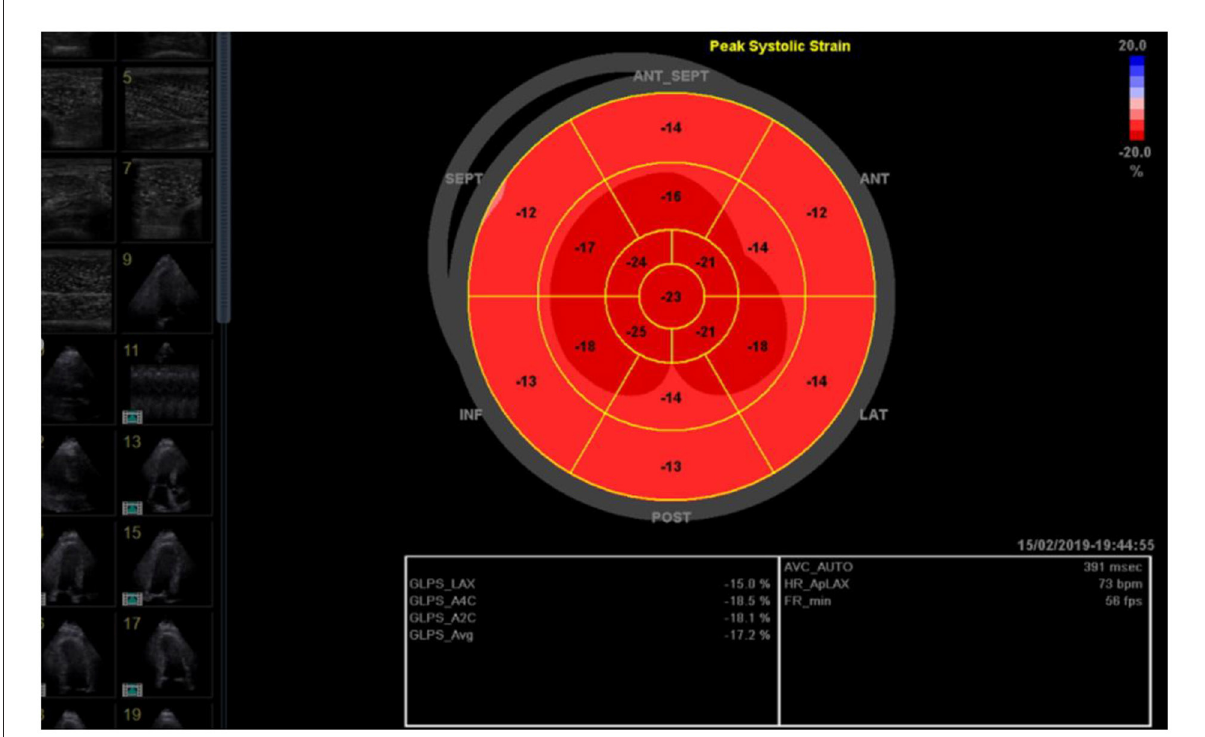
FIGURE2 Global longitudinal strain average (GLS avg; here − 17.2 %) as measured by a blinded cardiologist using images stored on an Echo PAC software.